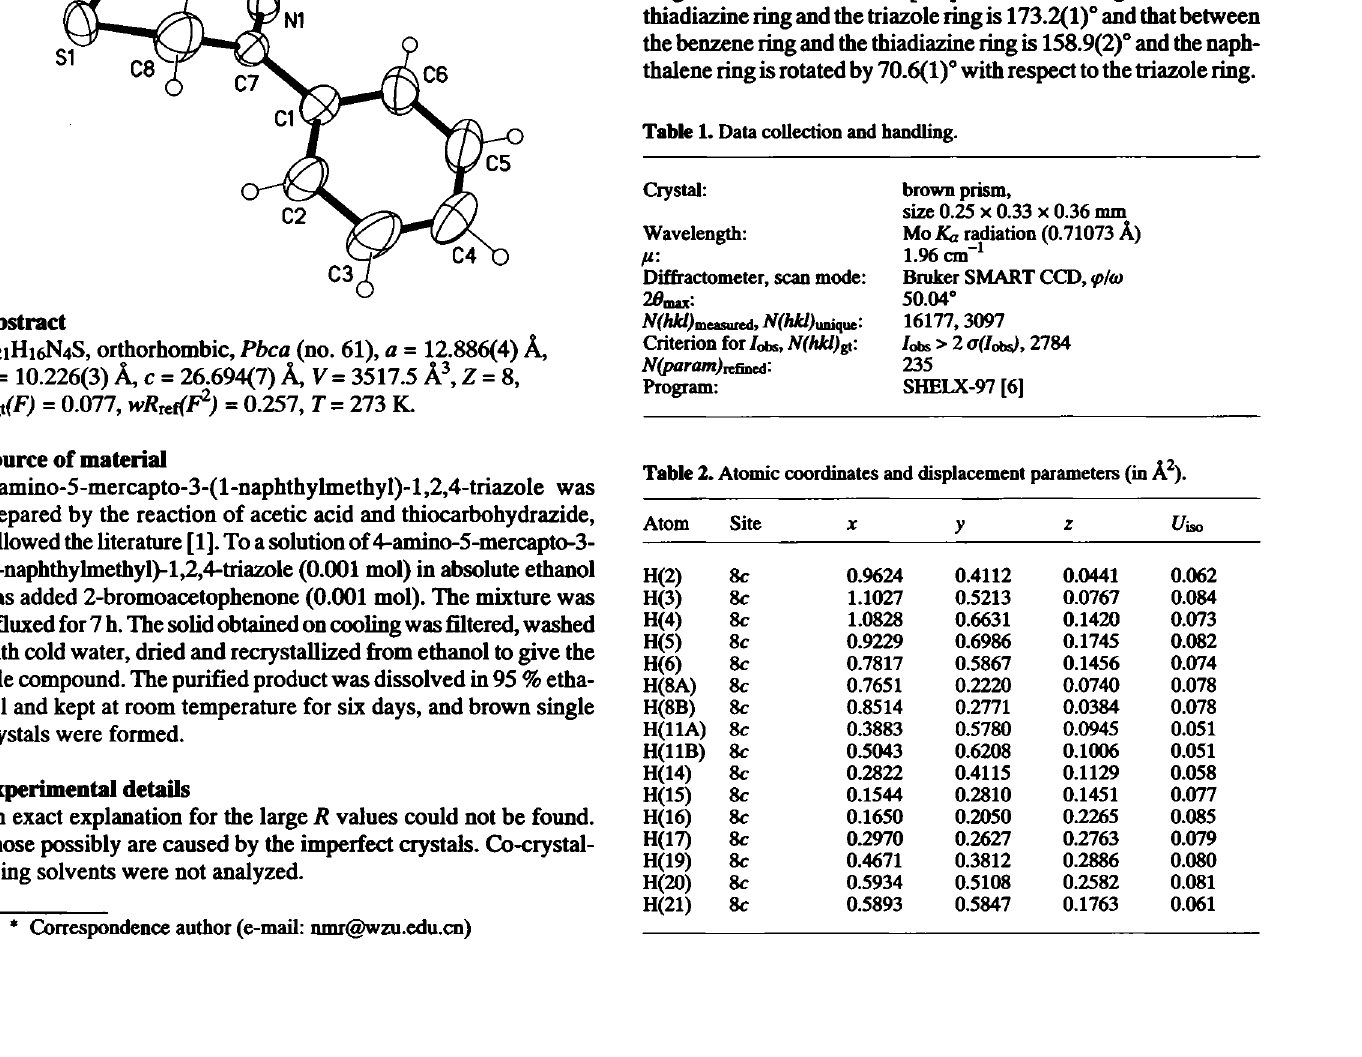
Table 1. Data collection and handling.